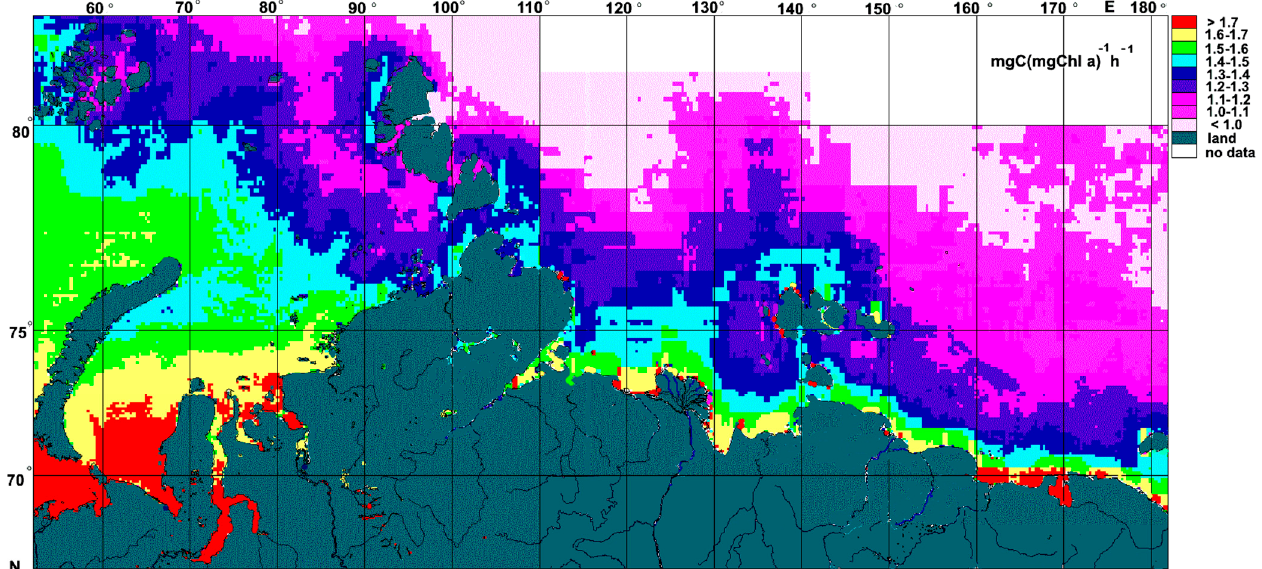
Figure 7. The representation of Siberian Seas estimates of the optimal assimilation number (P b opt ) from satellite climatologies (2007–2020) calculated using E 0reg model for the period from July to Oc- tober.